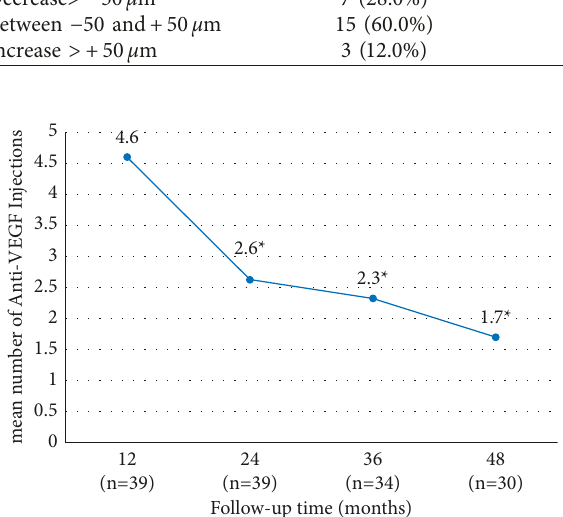
Figure 3: Mean number of injections per period until 48 months (primary outcome). The mean number of intravitreal injections was reduced significantly between 12 and 24 months ( P 0 . 007), be- (cid:31) tween 24 and 36 months ( P 0 . 003), and between 36 and 48 (cid:31) months ( P 0 . 002) compared with the number of injections (cid:31) performed in the first 12 months of